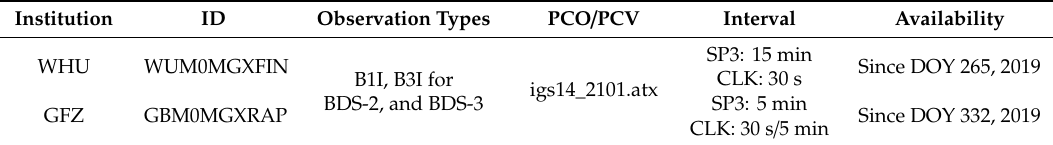
Table 1. The information of IGS precise products for BDS-3.